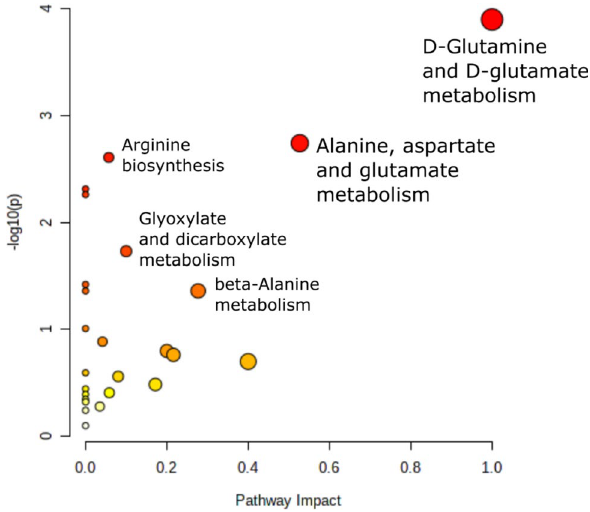
Figure 7. Pathway analysis of damselfly larvae exposed to wastewater effluent. The x-axis represents the pathway impact score (0–1) and the y-axis (−log(p-value)) marks the pathway enrichment score. Each circle marks a pathway, larger sizes and darker colours suggest higher pathway impact and higher pathway enrichment, respectively (lower